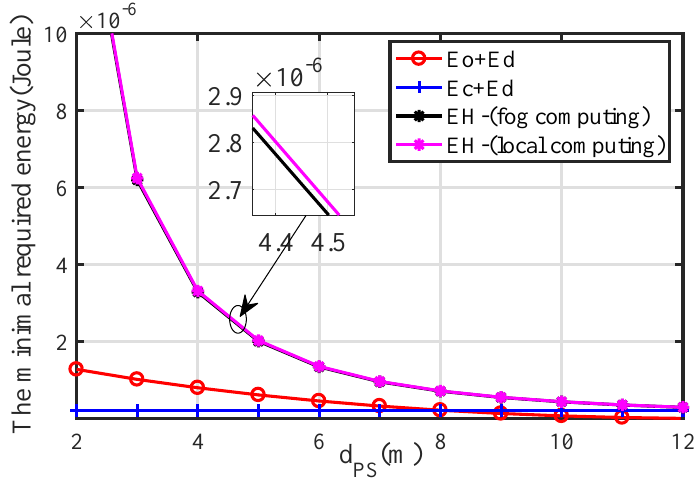
Figure 3. The minimal required energy and harvested energy versus d PS